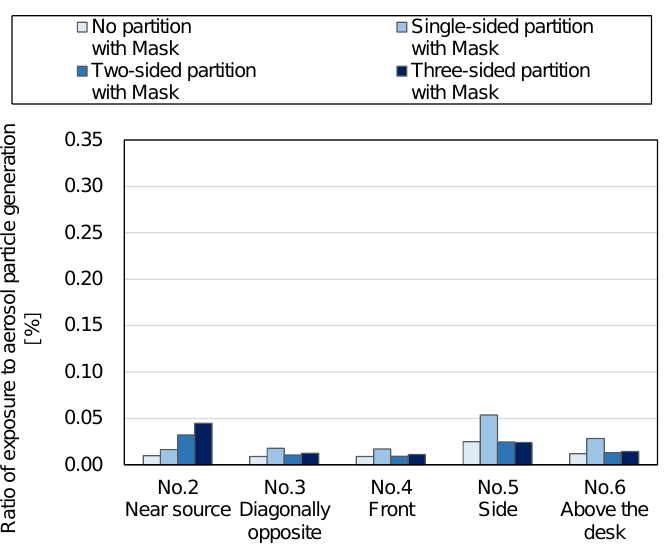
Figure 6. Effect of partition shape (without mask) [21].